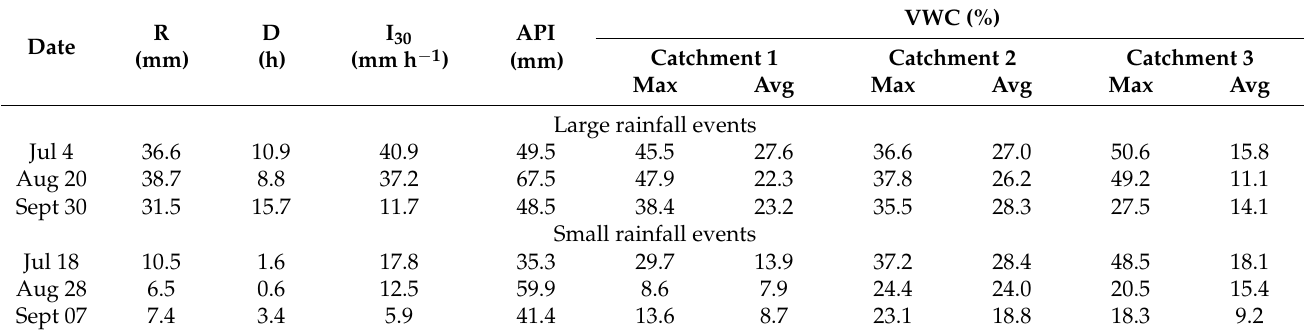
Table 4. Precipitation metrics and volumetric water content for three large rainfall events (>30 mm) and three small rainfall events (<10 mm) after thinning